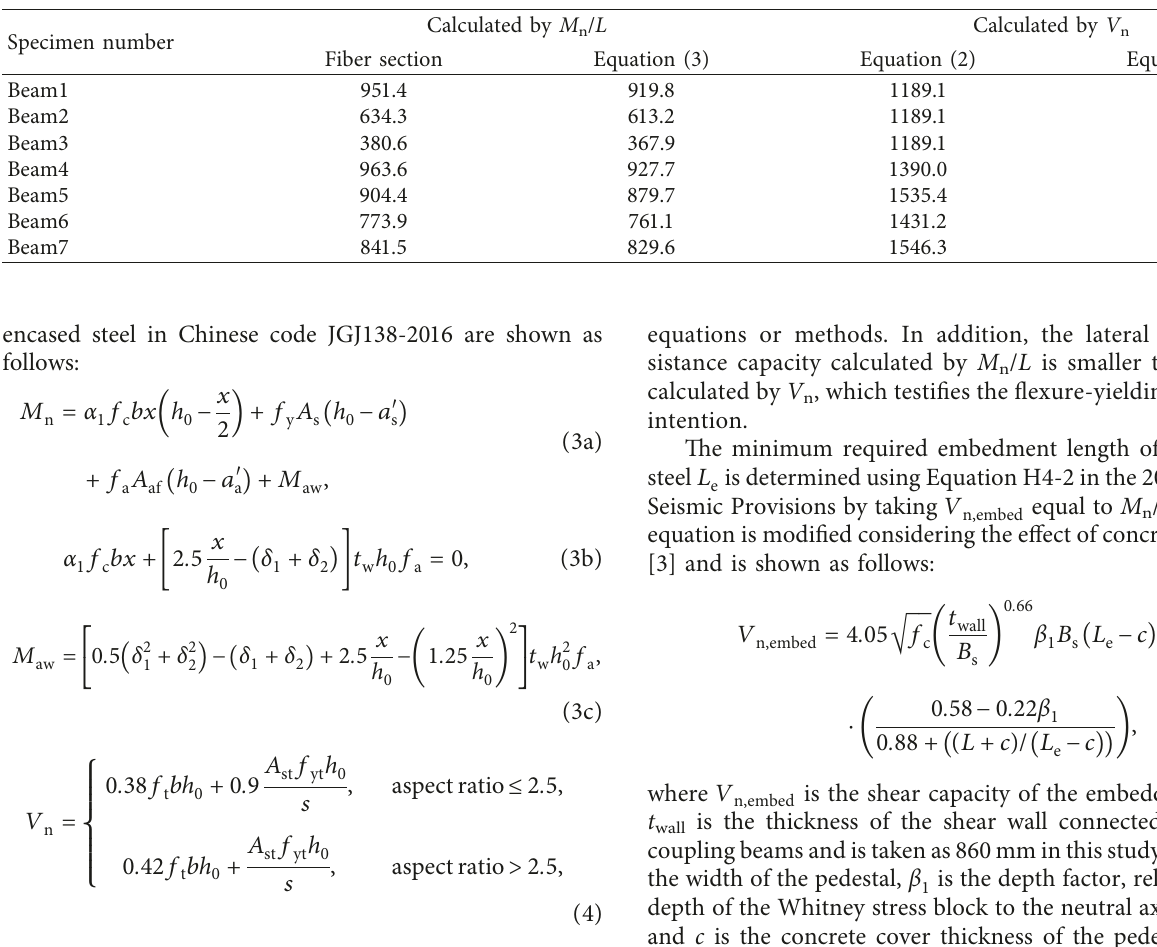
Table 3: Lateral load resistance capacity of specimens